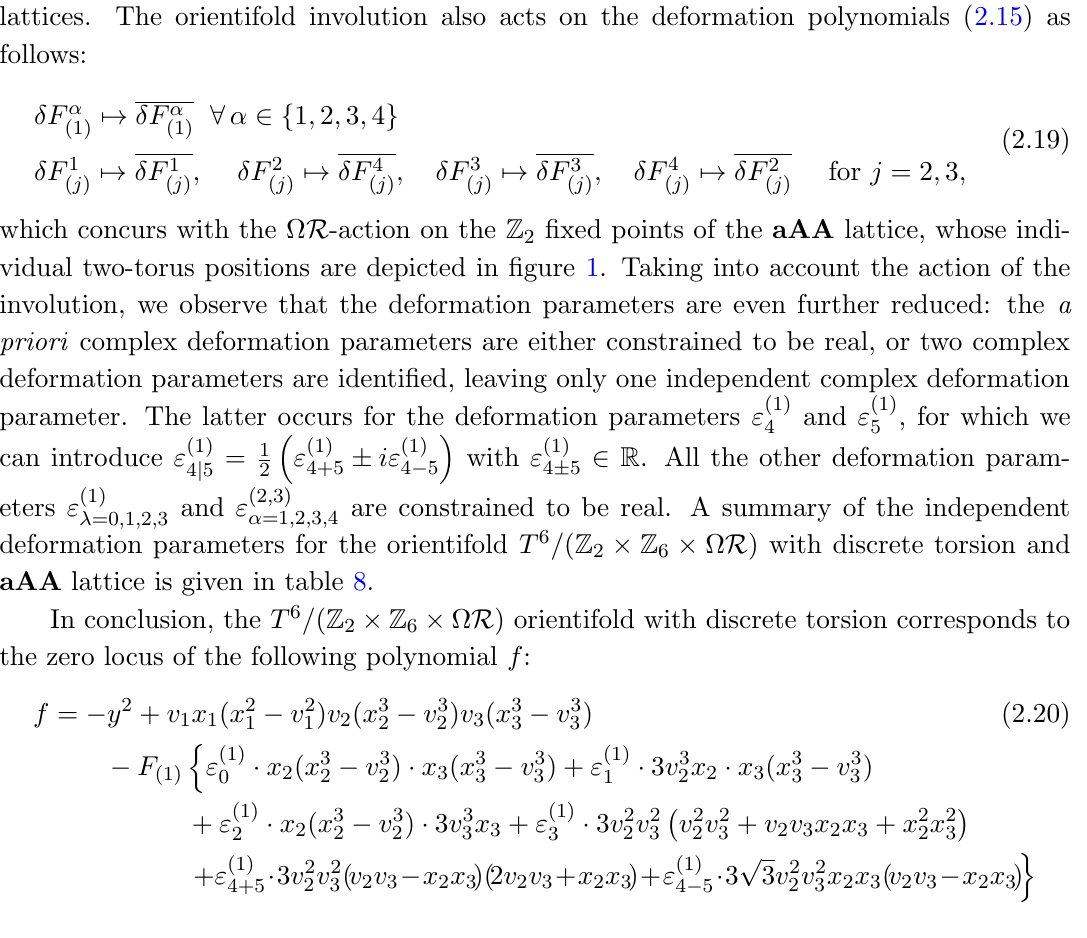
Overview of the independent deformation parameters per Z ( i ) T 6 = ( Z 2 (cid:2) Z 6 (cid:2) (cid:10) R ) with discrete torsion ( (cid:17) = (cid:0) 1) and the restrictions following from the Z 3